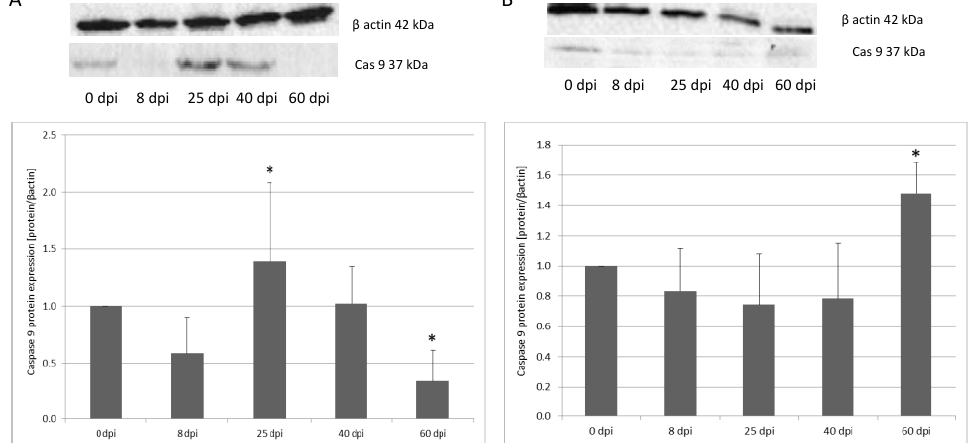
Figure 6. Representative Western blot bands and densitometric analysis of the caspase-9 protein level in the small intestine ( A ) and large intestine ( B ) from uninfected and H. diminuta -infected rats. Data represent the arithmetic mean ± SD and are representative of individual groups of six animals in each experiment. Statistical analysis was performed using the Kruskal–Wallis test, * p < 0.05 vs. 0 dpi.